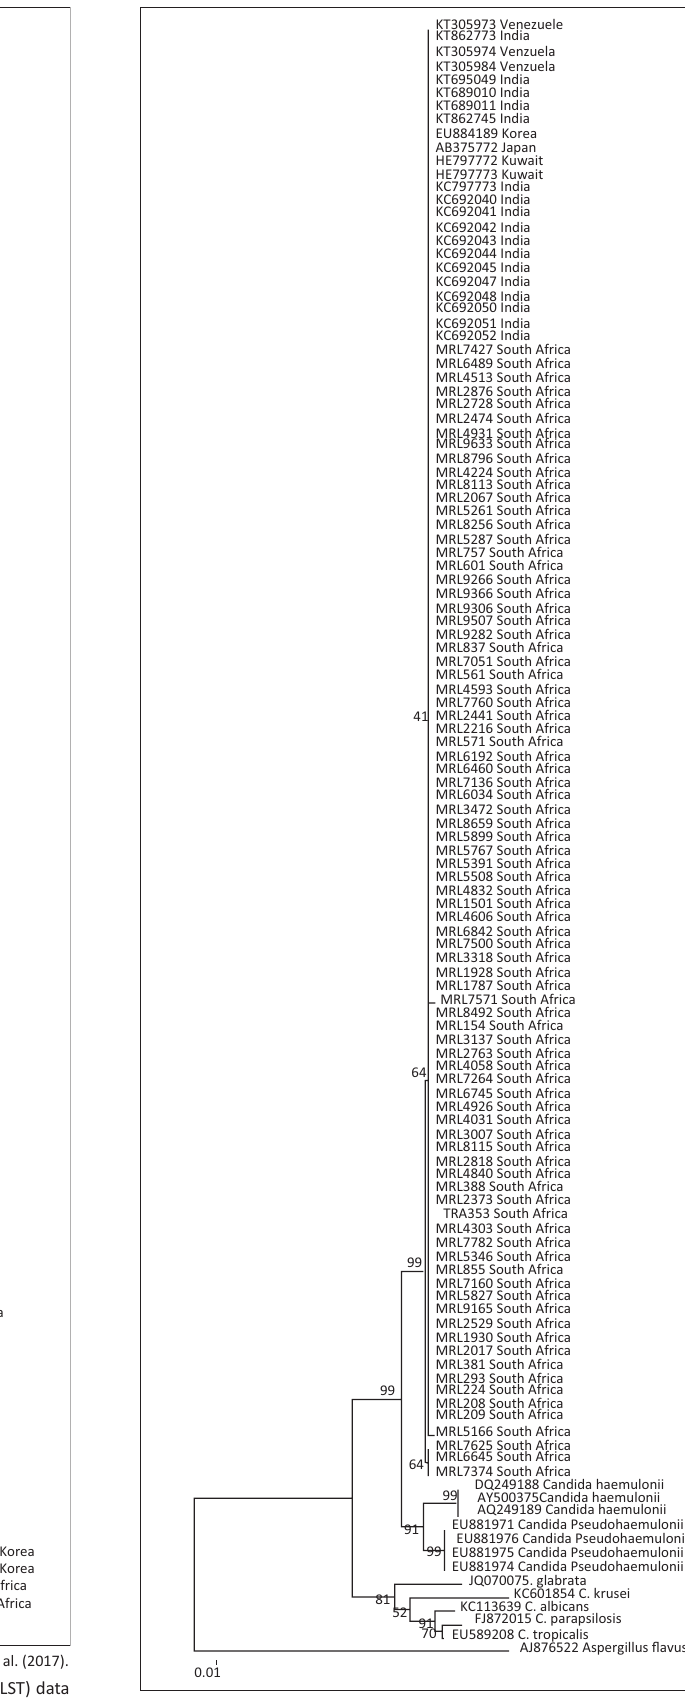
FIGURE 2: Phylogenetic tree of isolates of the Candida auris ( n = 85) obtained using neighbour-joining phylogenetic analyses and 2000 bootstrap replications based on internal transcribed spacer sequences.